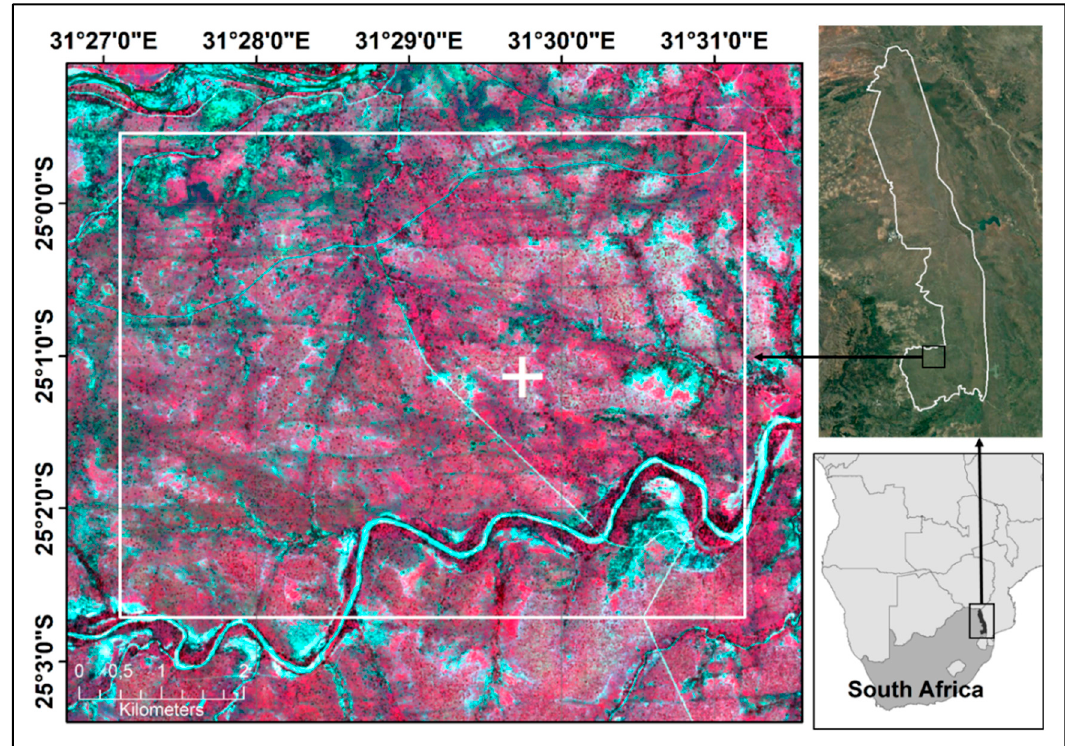
Figure 2. Location of the study area (ca. 50 km²) in the southern Kruger National Park (KNP) (Skukuza eddy covariance flux tower and in situ soil moisture probes, white cross) (Imagery source: Copernicus Sentinel-2A data 19 January 2017 (R: Band 8; G: Band 4; B: Band 3)/Google Earth/FAO Country Shape).